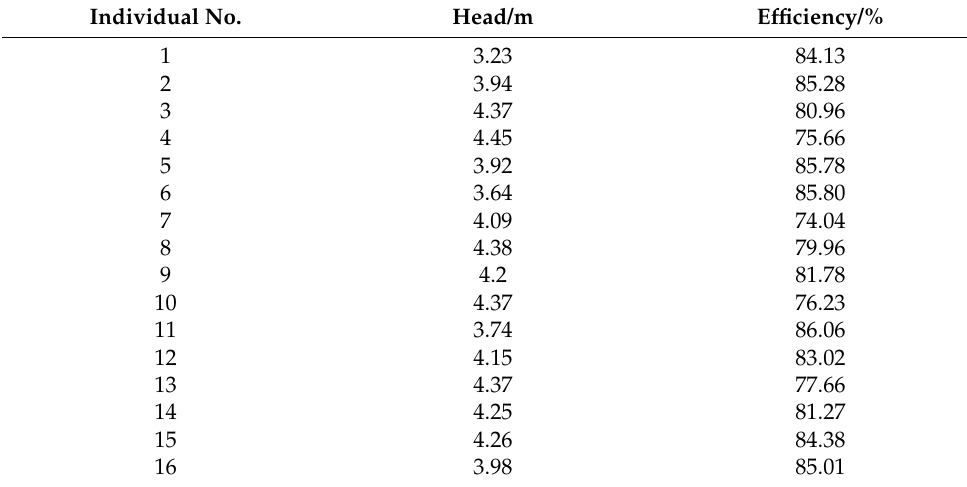
Table 4. Axial-flow pump performance.